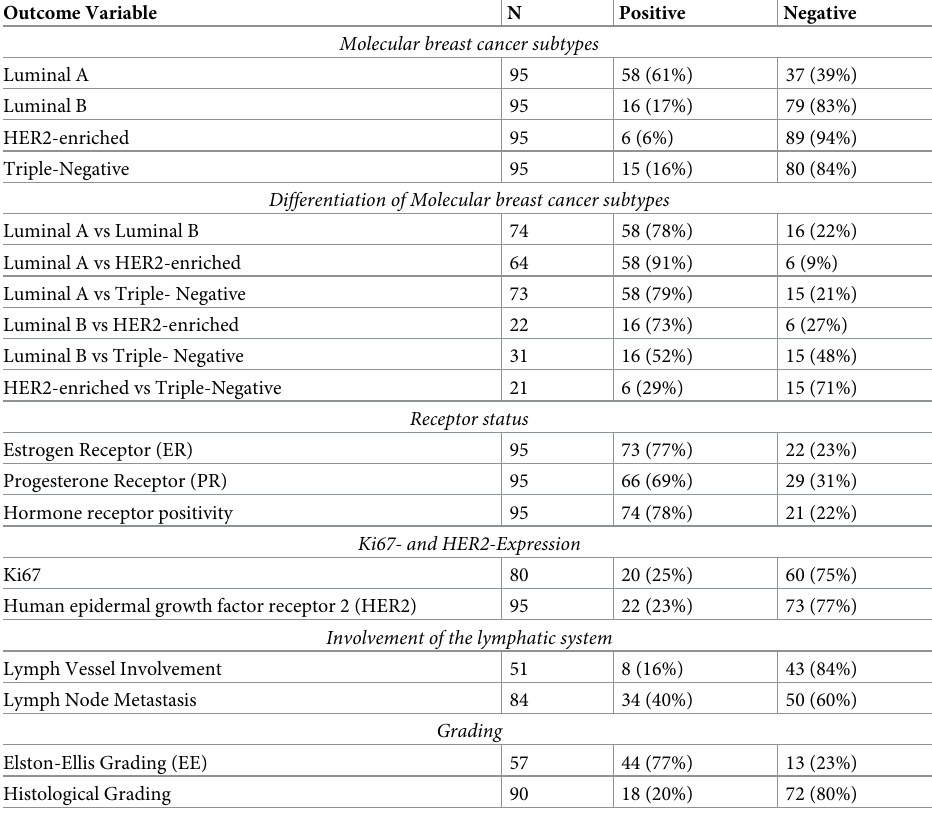
Table 1. Display of the distribution of the outcome variables. N denotes the sample size used for each outcome, while Positive and Negative denote the balance of the